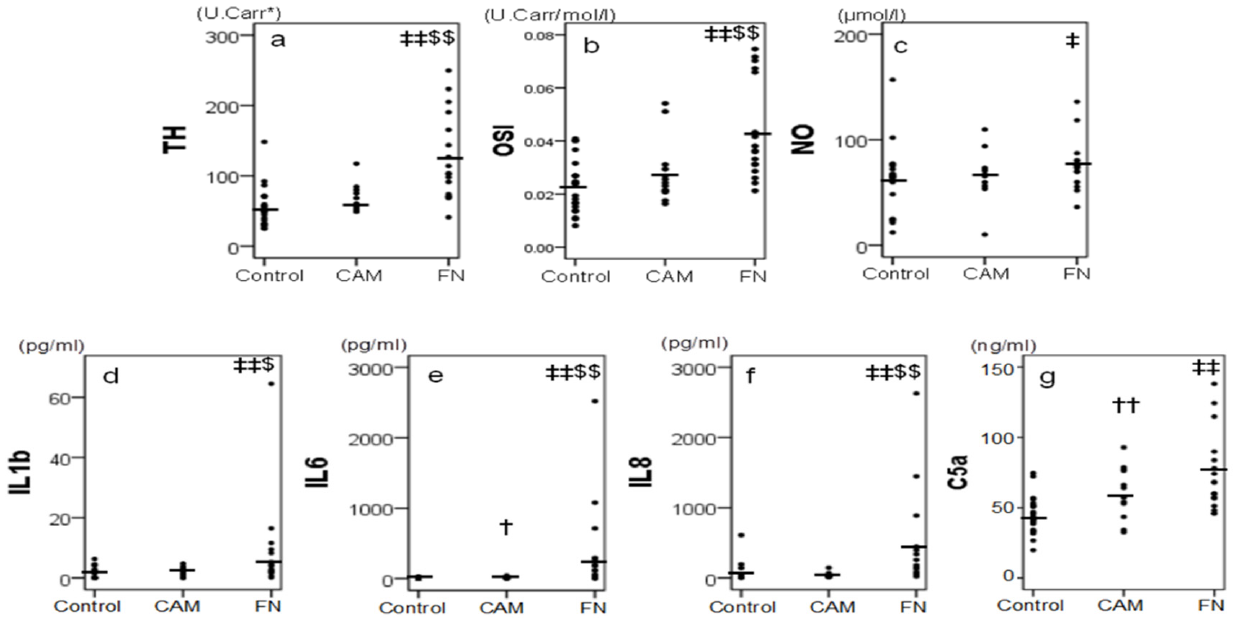
Figure 3. Serum cord blood levels of oxidative markers ( a ) TH, ( b ) OSI (TH/BAP) and ( c ) NOx, cytokines ( d ) IL-1b, ( e ) IL-6, ( f ) IL-8, and ( g ) C5a in 52 newborns: 22 healthy newborns without funisitis (FN) or chorioamnionitis (CAM) as a control group, 17 cases of FN, and 13 cases of CAM. † and ††: significant difference between control and CAM, p < 0.05 and 0.005, respectively, ‡ and ‡‡: significant difference between control and FN, p < 0.05 and 0.005, respectively, and $ and $$: significant difference between CAM and FN, p < 0.05 and 0.005, respectively. * The results of the TH are expressed in arbitrary conventional units, called Carr units, which are equal to a concentration of 0.08 mg/dl of hydrogen peroxide.